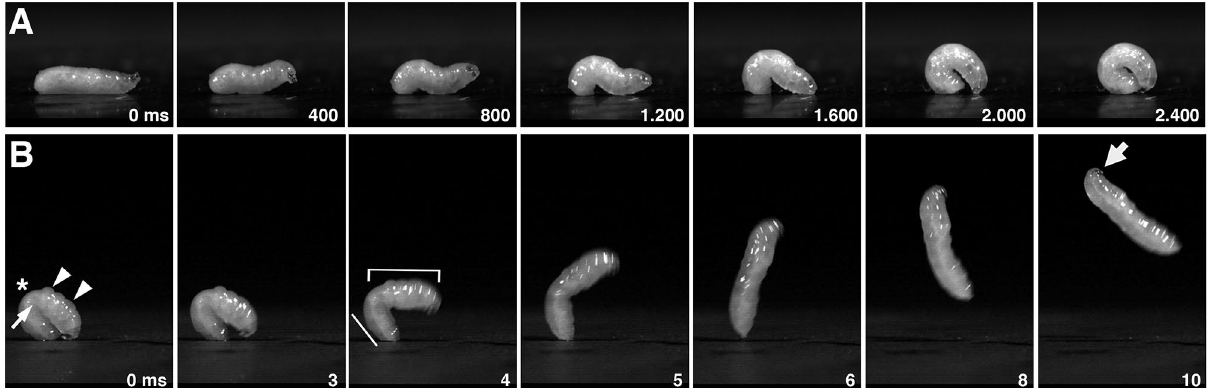
Figure 2. Jump preparation comprises two major steps in legless C. capitata larvae: Loop formation and loop contraction. ( A ) Loop formation consists of two phases: lifting and latching. With the head raised, larvae lift themselves into an upright, loop-like figure that is stabilized by planting both the head and caudal segment solidly on the substrate (800–1600 ms). During latching, mouth hooks insert firmly into the protruding ventral portion of the caudal segment, which closes the loop (2000–2400 ms). ( B ) During loop contraction or tension generation, larvae flatten (asterisk) and kink (arrow) at the most exposed region, which causes bulging and thickening of the anterior end (arrowheads, 0 ms). Take-off is triggered by mouth hook release (3 ms). Anterior segments (bracket) snap into the air, while the posterior end (white line) transduces the kinetic energy to the substrate (4–5 ms). Larvae fly forward but spin backward. Head and mouth hooks are retracted during flight (thick Launch and kinematics of the jump phase. While the posterior end of the larva was still in contact with the substrate, the whirling anterior part fuelled the jump (Fig. 2B, 4–5 ms). During this thrust phase, the anterior head region could be compared to a lever arm that rotates around the kink (pivot point) to transmit its force and kinetic energy to the load arm (posterior end) and thus the substrate. As soon as the body was completely straight, the larva lost contact to the substrate (Fig. 2B, 6 ms). Take-off time, the time between latch release and lift-off, was extremely fast and took only 3.29 ± 0.48 ms (n = 8). The larva left the ground at an average angle of 71 ± 5° (take-off angle), rotating backwards around its centre of gravity (Fig. 2B, 8–10 ms). Thus, the inclined posterior end and the soaring anterior end together cause the larva flying forward in backward somersaults. Without having any legs, Ceratitis larvae jumped on average 100 ± 38 mm (n = 40) from a standing position